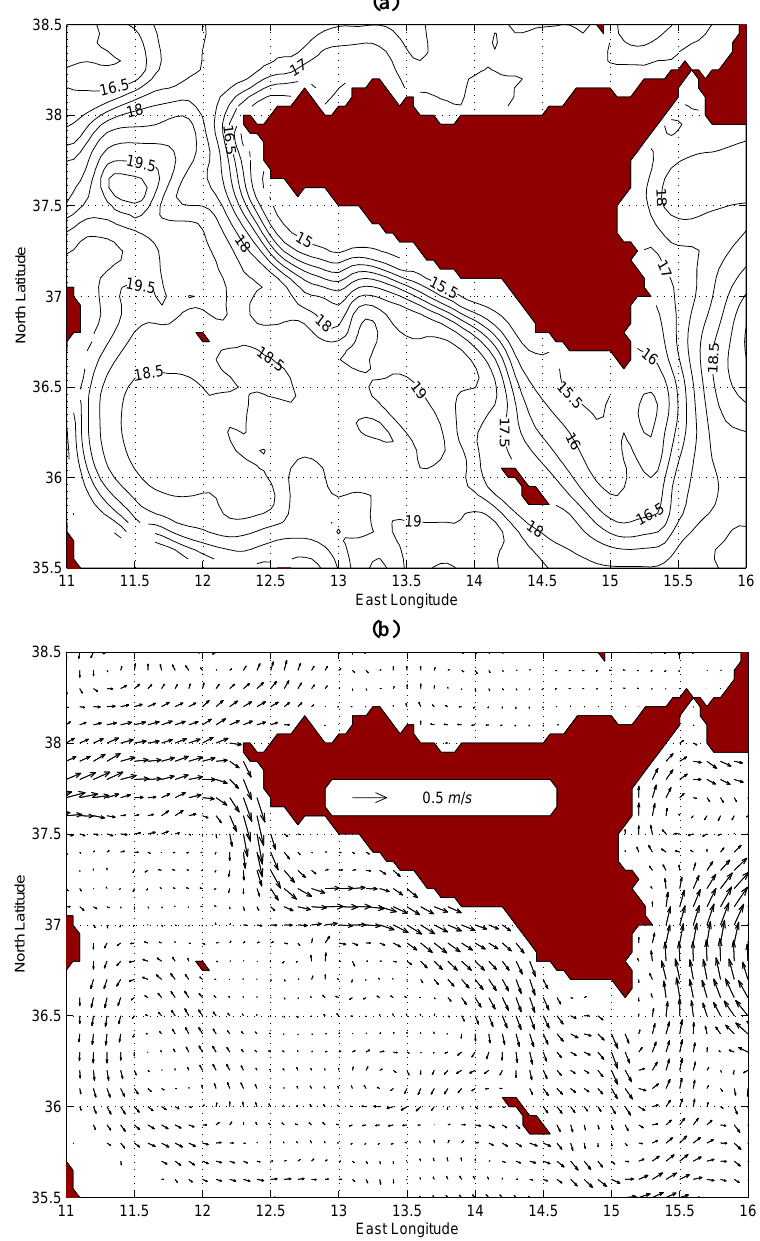
Fig. 18. Ten-day averaged (a) temperature and (b) total velocity fields at 30m depth during September. The temperature contour interval is 0.5 ◦ C. One vector every two grid points is plotted for velocity. Units are m/s. accompanied by strong velocity shears in the bottom bound- ary layer and along its lateral boundaries as it extends hori- zontally down to a latitude of 36.4 ◦ N, and vertically beyond the Sicilian shelf